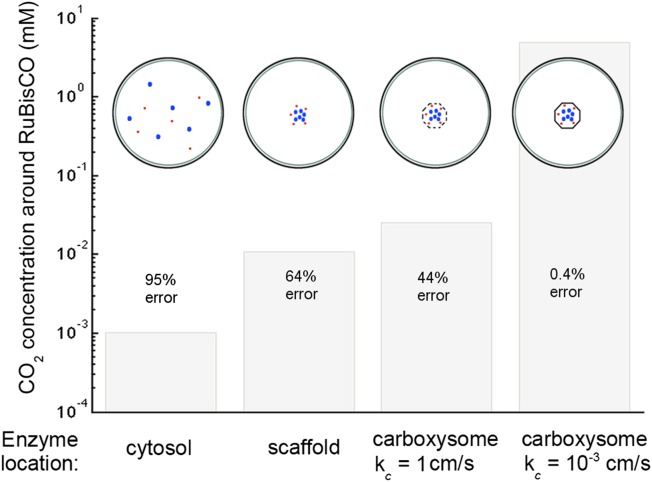
Concentration of CO2 achieved through various cellular organizations of enzymes, where we have selected the HCO3− transport level such that the HCO3− concentration in the cytosol is 30 mM.O2 concentration is 260 μM. The oxygenation error rates, as a percent of total RuBisCO reactions are indicated on the concentration bars. The cellular organizations investigated are RuBisCO and carbonic anhydrase distributed throughout the entire cytosol, co-localizing RuBisCO and carbonic anhydrase on a scaffold at the center of the cell without a carboxysome shell, RuBisCO and carbonic anhydrase encapsulated in a carboxysome with high permeability at the center of the cell, and RuBisCO and carbonic anhydrase encapsulated in a carboxysome with optimal permeability at the center of the cell.